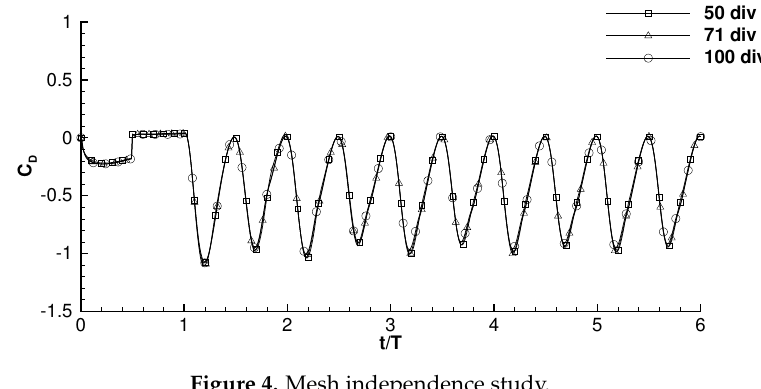
Figure 4. Mesh independence study.